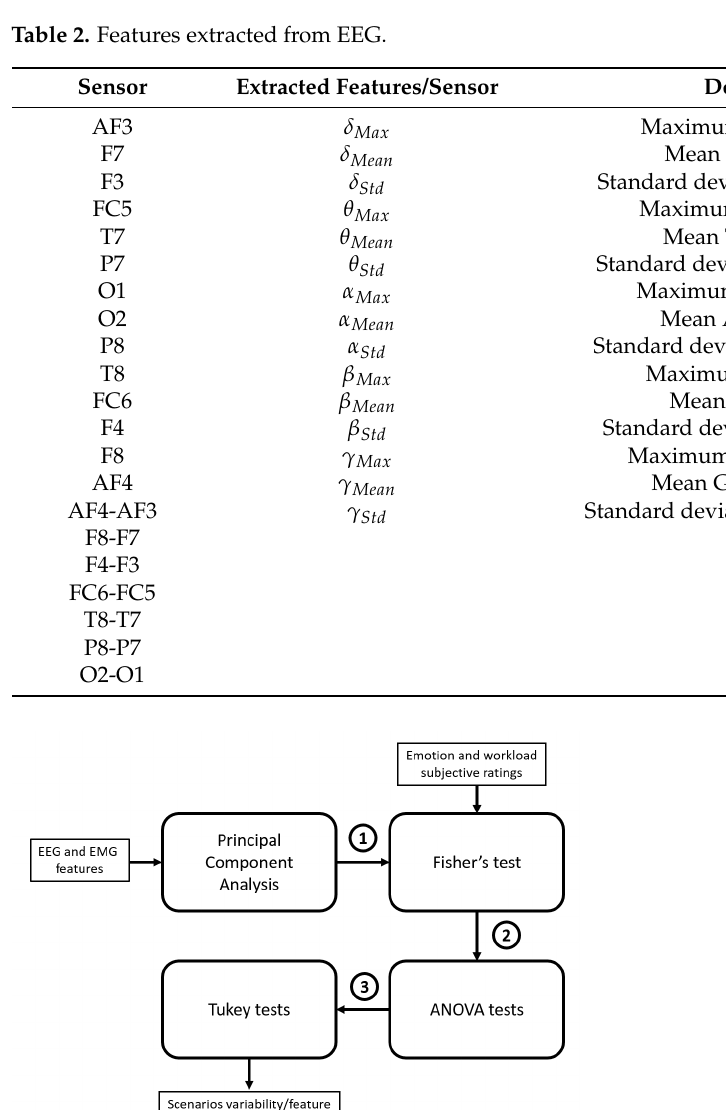
Figure 7. Statistics analysis methodology: presentation of the outputs of each block: 1—uncorrelated features after PCA selection. 2—Correlated features with subjective ratings. 3—Features where at least two scenarios were